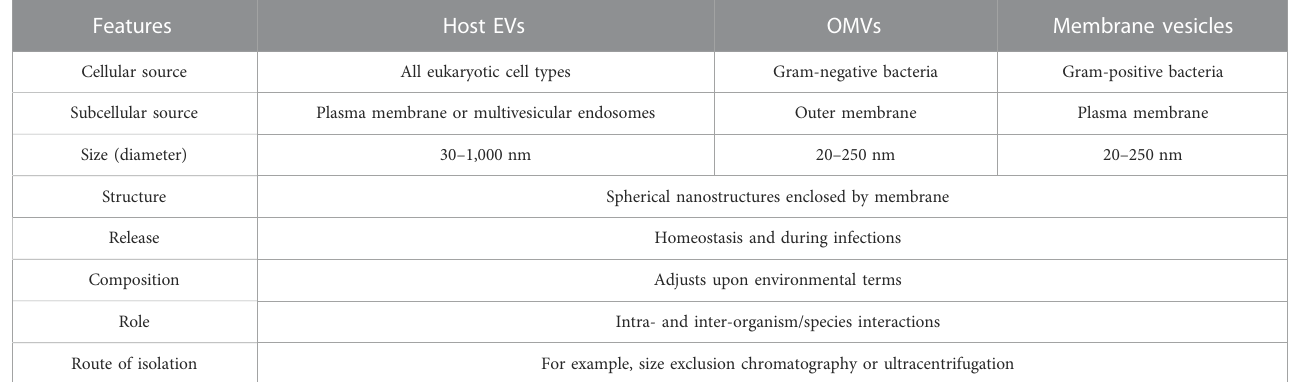
TABLE 1 Overlapping and distinguishing characteristics of EV populations (Jung et al.,